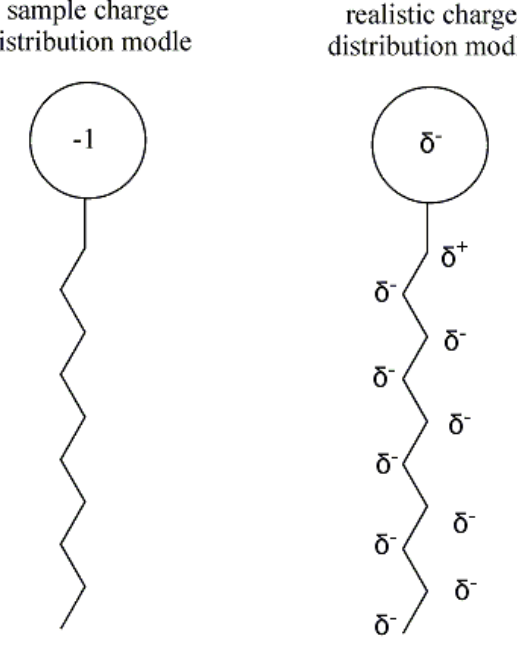
Figure 3. For ionic surfactants, quantum chemical calculations suggest that the charge is distributed throughout the molecule